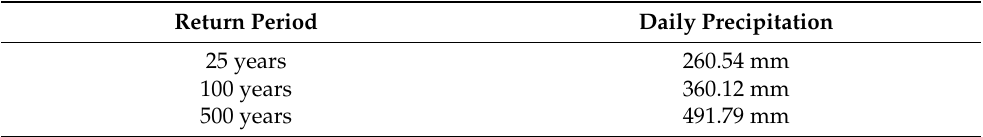
Table 3. Maximum daily precipitation obtained for each return